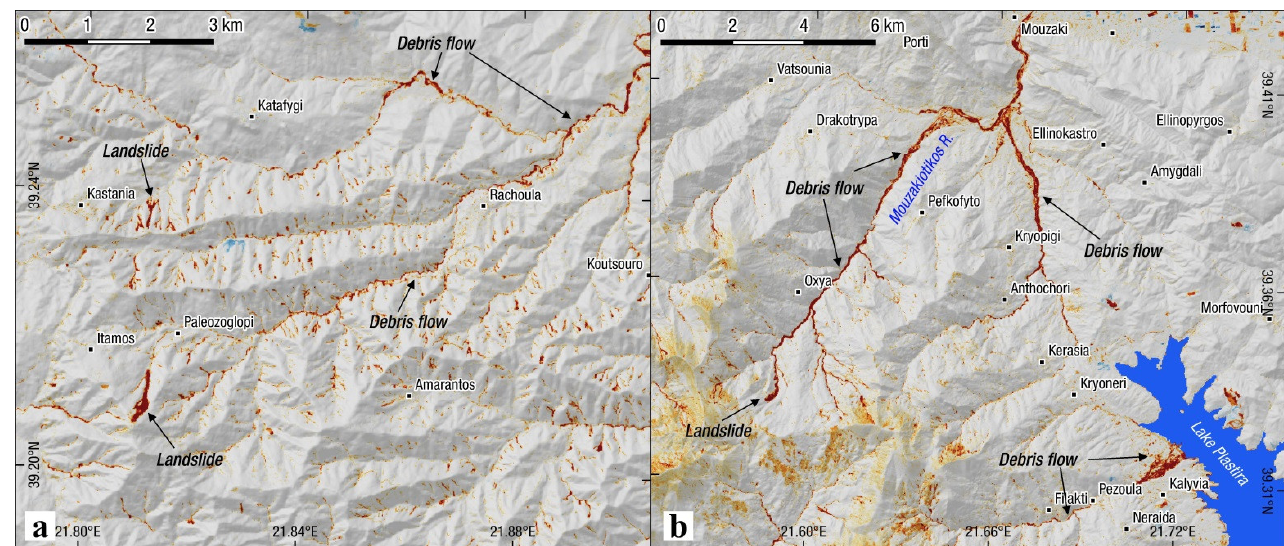
Figure 15. Change detection results from HazMapper [44,48] utilizing multi-temporal Sentinel-2 imagery. Red colors show negative rdNDVI changes that correspond to land cover changes due to landslides and debris flows. Results were in par with manual mapping in the area of high-density landslides southeast of Plastira Lake ( a ), while in most areas change detection was more successful in depicting the major debris flows such as the ones upstream of Mouzakiotikos River ( b ).